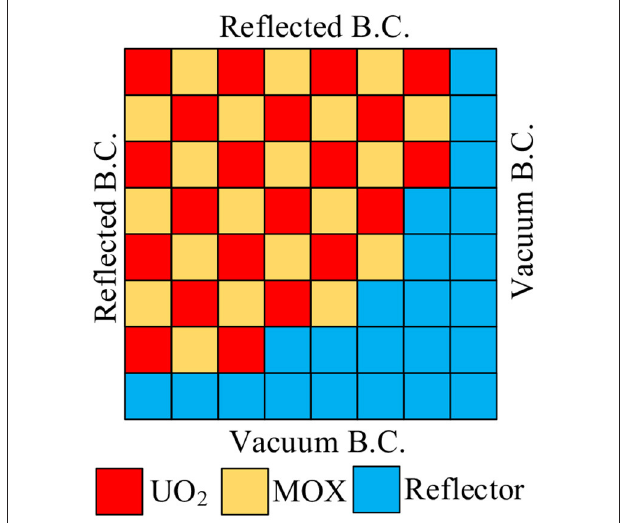
FIGURE 4 | A mock PWR quarter core.